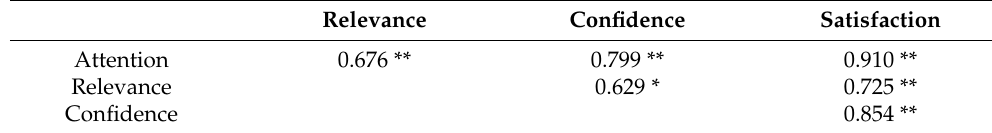
Table 4. Spearman’s correlation